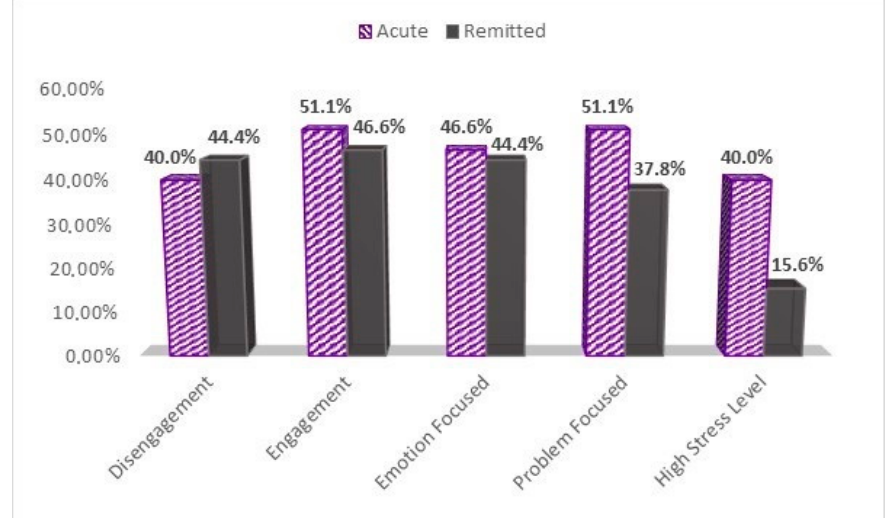
Figure 1. High level of stress and coping strategies between the study groups. Graphical description of patients’ proportions scoring ≥ 3 on the COPE-60 questionnaire, and higher than the median score of 14 on the NSESSS, or higher than 44 on the PCL-C to assess high stress levels. As shown in Table 2, a higher level of income was significantly correlated to the re- mitted patients’ group (r = 0.300, p -value = 0.004), while among the studied comorbidities, diabetes was positively correlated to non-acute patients (r = 0.255, p -value = 0.015). A negative correlation was significantly found between the level of stress and disease category (r = − 0.398, p -value < 0.001), thus patients in the acute COVID-19 study group experienced higher stress levels than remitted COVID-19 patients. There were no significant correlation findings regarding coping strategies and the category of the disease. There was a significant association between male gender and disease severity (r = 0.321, p -value = 0.002), as well as for old age (r = 0.386, p -value <0.001). By civil status, widowed patients were negatively cor- related with disease severity (r = − 0.226, p -value = 0.019). The comorbidities that were tightly associated to severe COVID-19 cases were cardiovascular diseases (r = 0.246, p -value = 0.019), and diabetes (r = 0.236, p -value = 0.025). Overall, the four clusters of coping strategies that were analyzed here did not have any significant correlation to disease severity. Table 2. Correlation analysis between disease category or disease severity and general characteristics, comorbidities, and coping strategies. Disease Category (Acute/Remitted) Disease Severity Disease